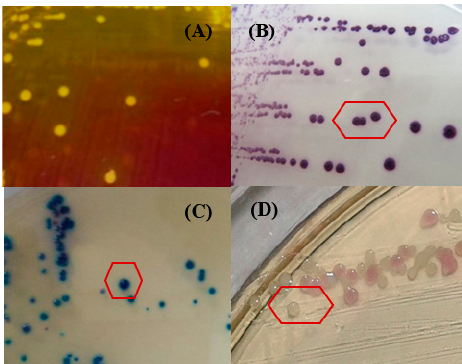
Figure 1. Staphylococcus spp. morphotypes obtained on Chapman agar ( A ) and CHROM TM Staph agar ( B : S. aureus ATCC 43300; C : S. haemolyticus ; D : S. warneri ). On CSA, three morphotypes characterizing the Staphylococcus species were noted (Table 1): 35.67% mauve colonies ( S. aureus : Figure 1B) as compared to S. aureus ATCC 43,300 reference strain, 29.14% light blue colonies ( S. haemolyticus : Figure 1C), and 35.17% white colonies ( S. warneri : Figure 1D). Table 1. Morphotypes of Staphylococcus spp. strains isolated from CHROM TM Staph agar based on the color scale. Organism (No. Tested) Color of Isolated Colonies Methicillin susceptible (1) Mauve Methicillin resistant (18) Mauve S. haemolyticus (2) Light blue S. warneri (3) White